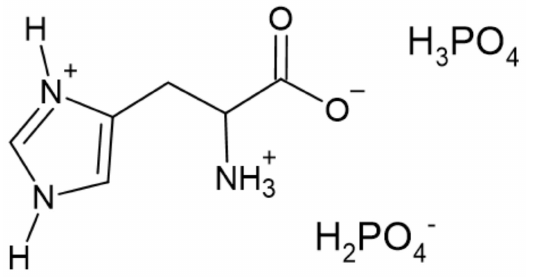
Figure 20. The structure of the L-histidinium dihydrogen phosphate–phosphoric acid